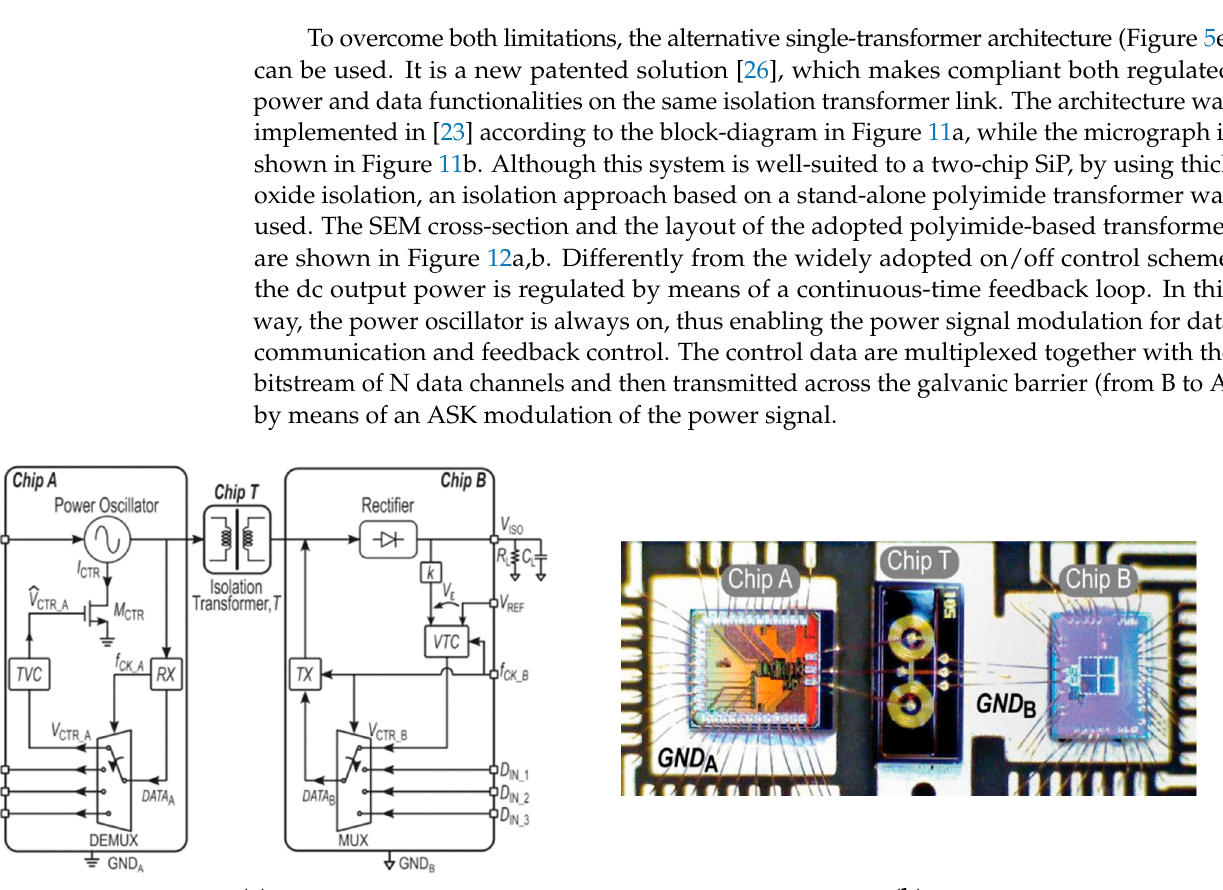
Figure 11. Single-transformer DC–DC converter with bidirectional data communication and power regulation. ( a ) Block diagram. ( b ) Micrograph. Reproduced from [23]. Copyright 2020, IEEE.